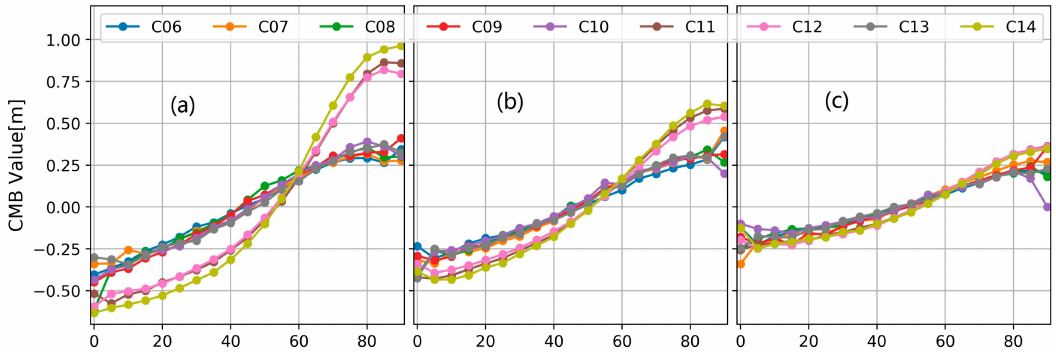
Figure 3. The CMB values estimated by our proposed model. ( a ) the values at the B1 frequency; ( b ) the values at the B2 frequency; ( c ) the values at the B3